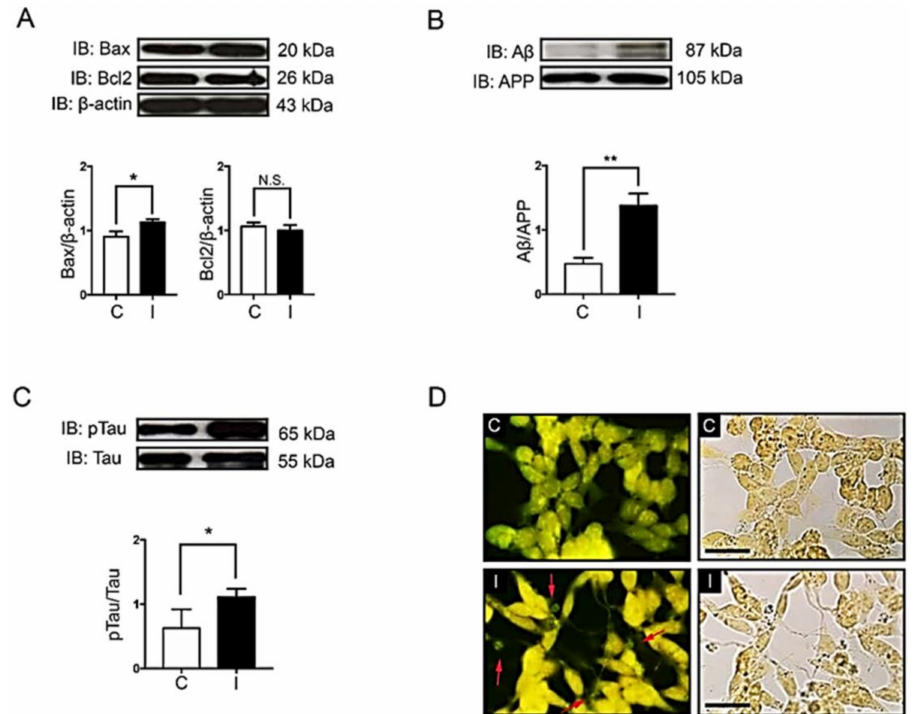
Figure 3. E ff ects of hyperinsulinemic conditions on apoptotic signals, A β and tau proteins. The normal cells (C) and insulin-resistant cells (I) were used to determine protein expression, including apoptotic signal proteins Bax and Bcl-2 ( A ), A β ( B ) and pTau (Ser396) ( C ). The Western blotting bands and bar graphs represent densitometric values of each lane after normalizing with total protein actin, amyloid precursor protein (APP), and tau protein, respectively. Values are mean ± SEM; * p < 0.05, ** p < 0.01 compared with normal cells (C). Thioflavin-S staining of neuritic plaques was done in SH-SY5Y cells ( D ). C and I represent the control and insulin-resistant groups, respectively. The stained cells were visualized by fluorescent microscope at 40X magnification. Red arrows indicate Thioflavin-S stained neuritic plaques. Scale bar, 25 µ m. All experiments shown were from n =